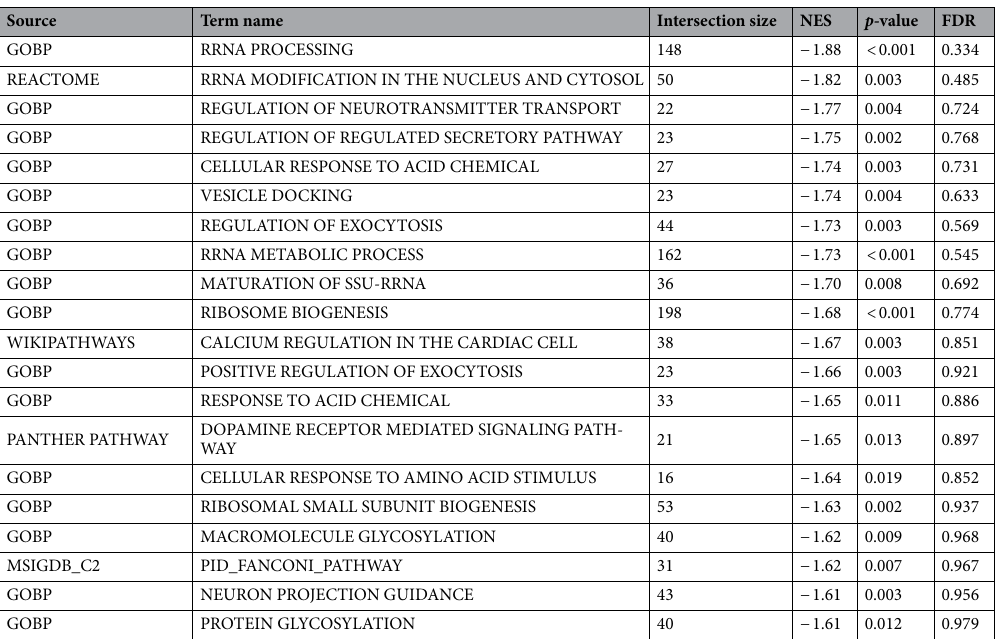
Table 4. Functional terms downregulated by the β-arrestin-preferring agonist BM138 as determined by gene set enrichment analysis. The 20 functional terms with the lowest NES are